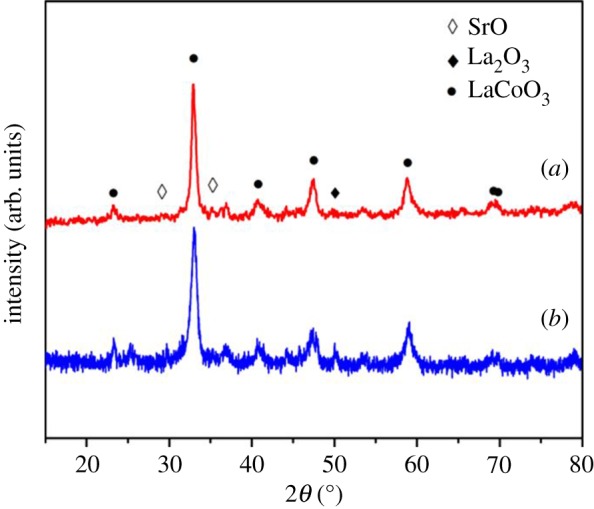
XRD patterns of fresh (a) and re-used (b) La0.6Sr0.4CoO3 perovskite catalysts.